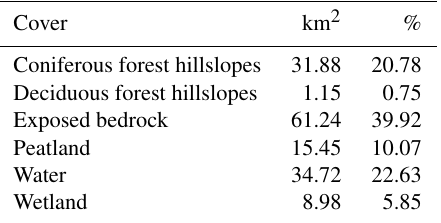
Table 1. Land cover percentages from SPOT-5 classification exer- cise.